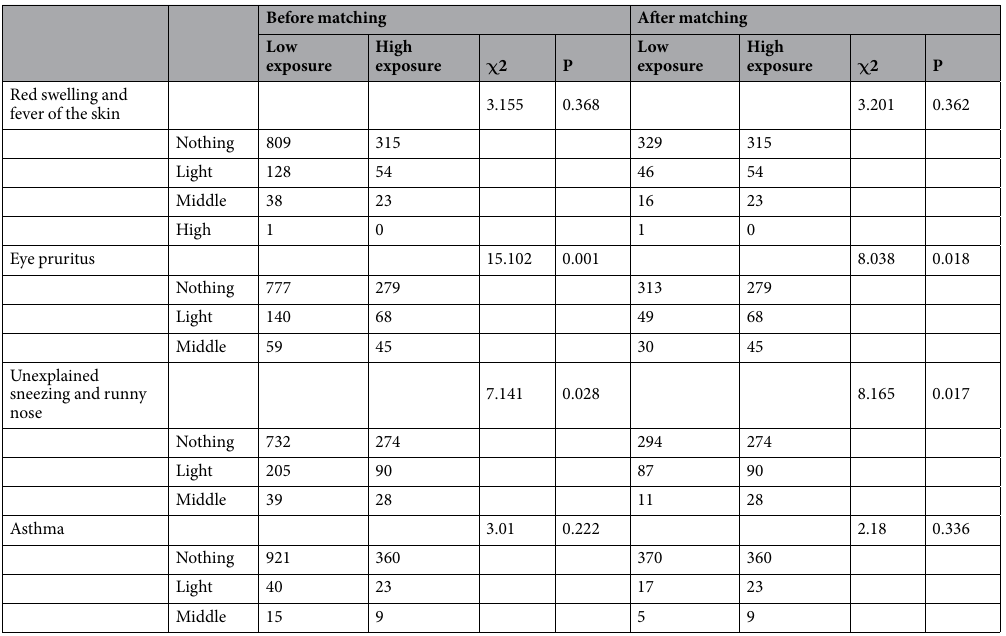
Table 4. Difference Test of Frequency of Stimulation Symptoms before and after